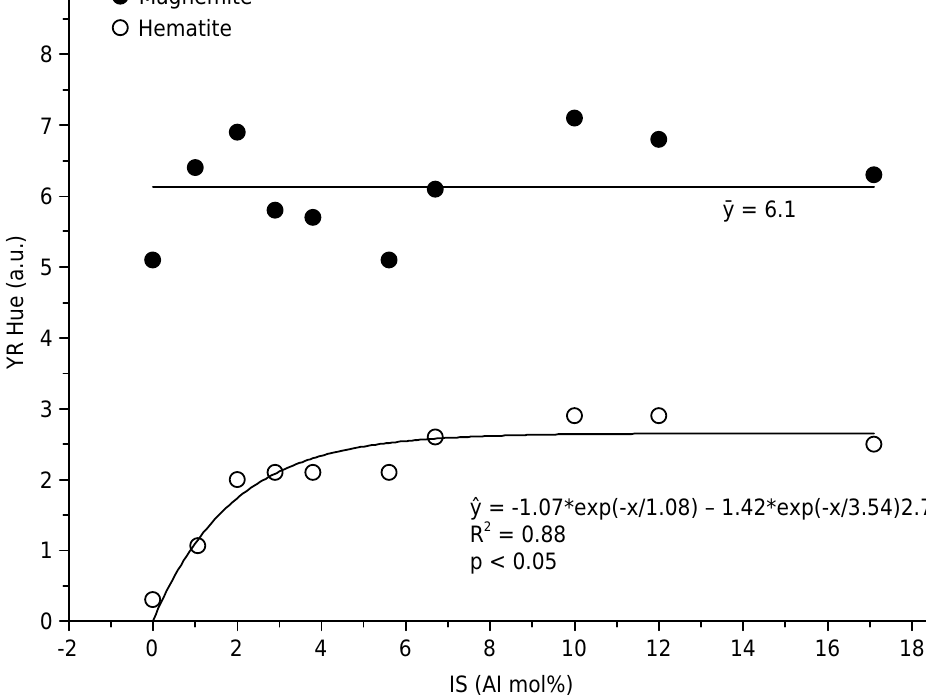
Figure 2. Relationship between YR hue values of synthetic Al-substituted maghemites (a) and hematites (b) samples. a.u.: arbitrary